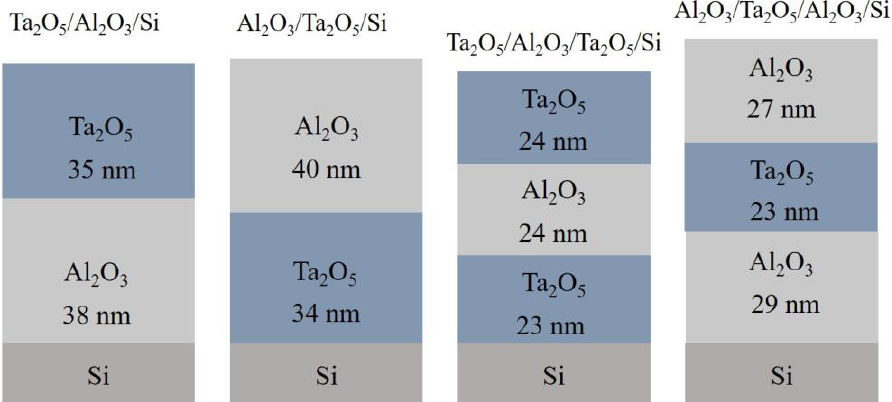
Figure 1. Schematics of the layered structure of the investigated laminates with notations shown above. Layer thickness determined with XRR with error ± 1 nm.